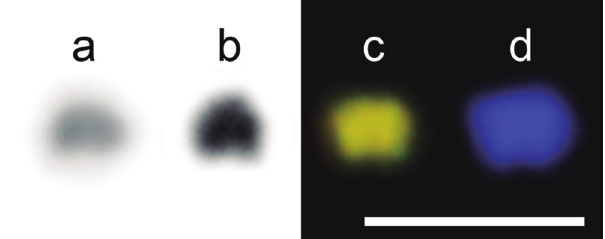
Fig. 5. The ill-defined acrocentric B chromosome: (a) Giemsa stained; (b) C-banded; stained by (c) CMA The bar represents